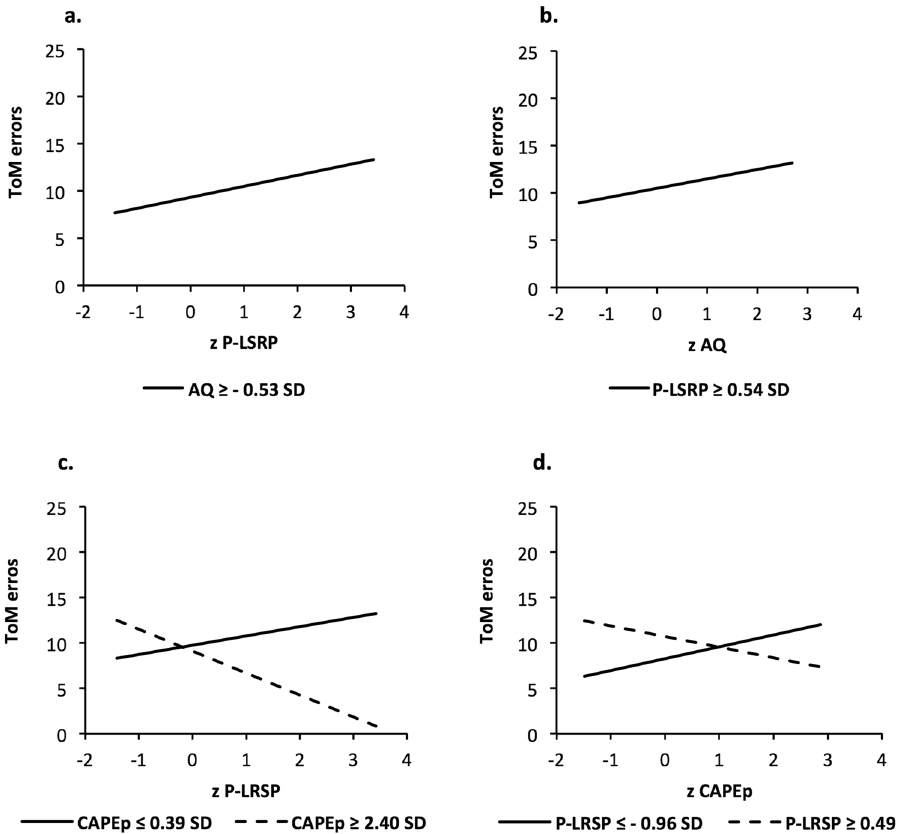
Figure 1. Visualization of the interactive effect of primary psychopathy (P-LSRP) and autism traits (AQ), and of P-LSRP and positive psychotic experiences (CAPEp) on overall theory of mind (ToM) errors. For all panels ( a – d ), regression lines represent the significant zone (p ≤ 0.05) of the focal predictor at the specified value of the other predictor. Panels 1a and 1b probe the interaction between the P-LSRP and AQ scores. Panel 1a shows that increasing P-LSRP scores significantly increases ToM errors when AQ scores are equal or more than − 0.53 SD from the mean. Panel 1b shows that increasing AQ scores significantly increase ToM errors when P-LSRP scores are equal or more than 0.54 SD from the mean. Panels 1c and 1d probe the interaction between the P-LSRP and CAPEp scores. Panel 1c shows that increasing P-LSRP scores significantly increase ToM errors when CAPEp scores are equal or less than 0.39 SD from the mean, but reduce ToM errors when CAPEp scores are more than 2.40 SD from the mean. Panel 1d shows that increasing CAPEp scores significantly increase ToM errors when P-LSRP scores are equal or less than − 0.96 SD from the mean, but reduce ToM Errors when P-LSRP scores are equal or more than 0.49 SD from the